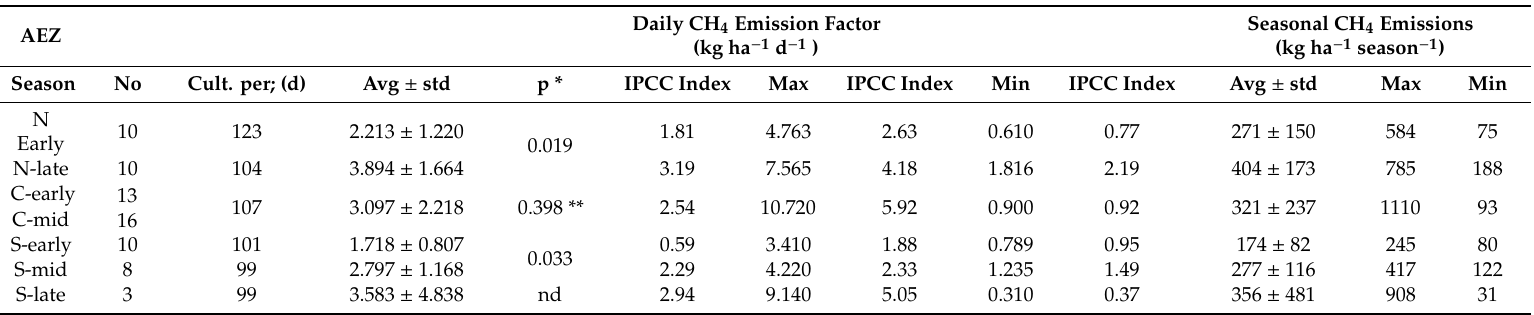
* The statistical significance value (p) at the confidence of 95% determined by one-way ANOVA. (p ≤ 0.05: average emission factor of the two seasons are statistically significant di ff erent). ** p- value based on seasonal averages and standard deviations of 2.844 ± 1.380 (C-early) and 3.126 ± 1.687 (C-mid), respectively; due to insignificant di ff erences, the two seasonal data sets were merged into